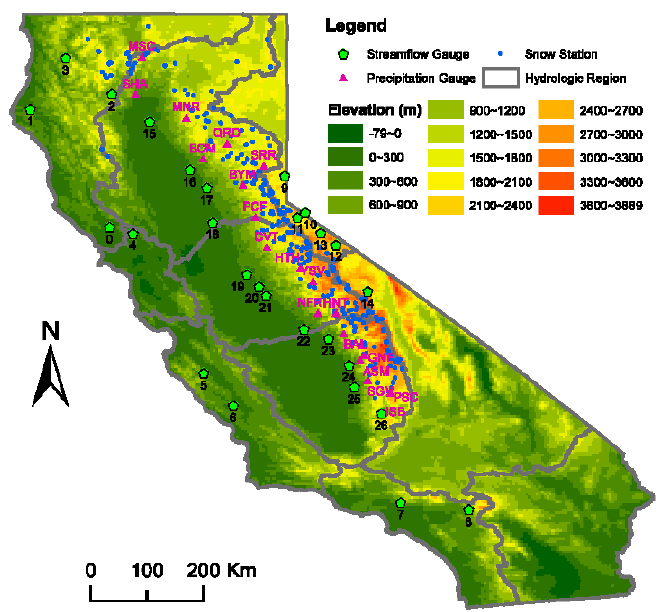
Figure A2. Location map of streamflow gauges (applied in determined runoff indices and water supply indices as well as regional runoff volume), precipitation gauges (applied in calculating precipitation indices), snow stations (applied in computing April 1st Snow Water Equivalent). Table A1. Precipitation gauges applied in calculating precipitation indices.